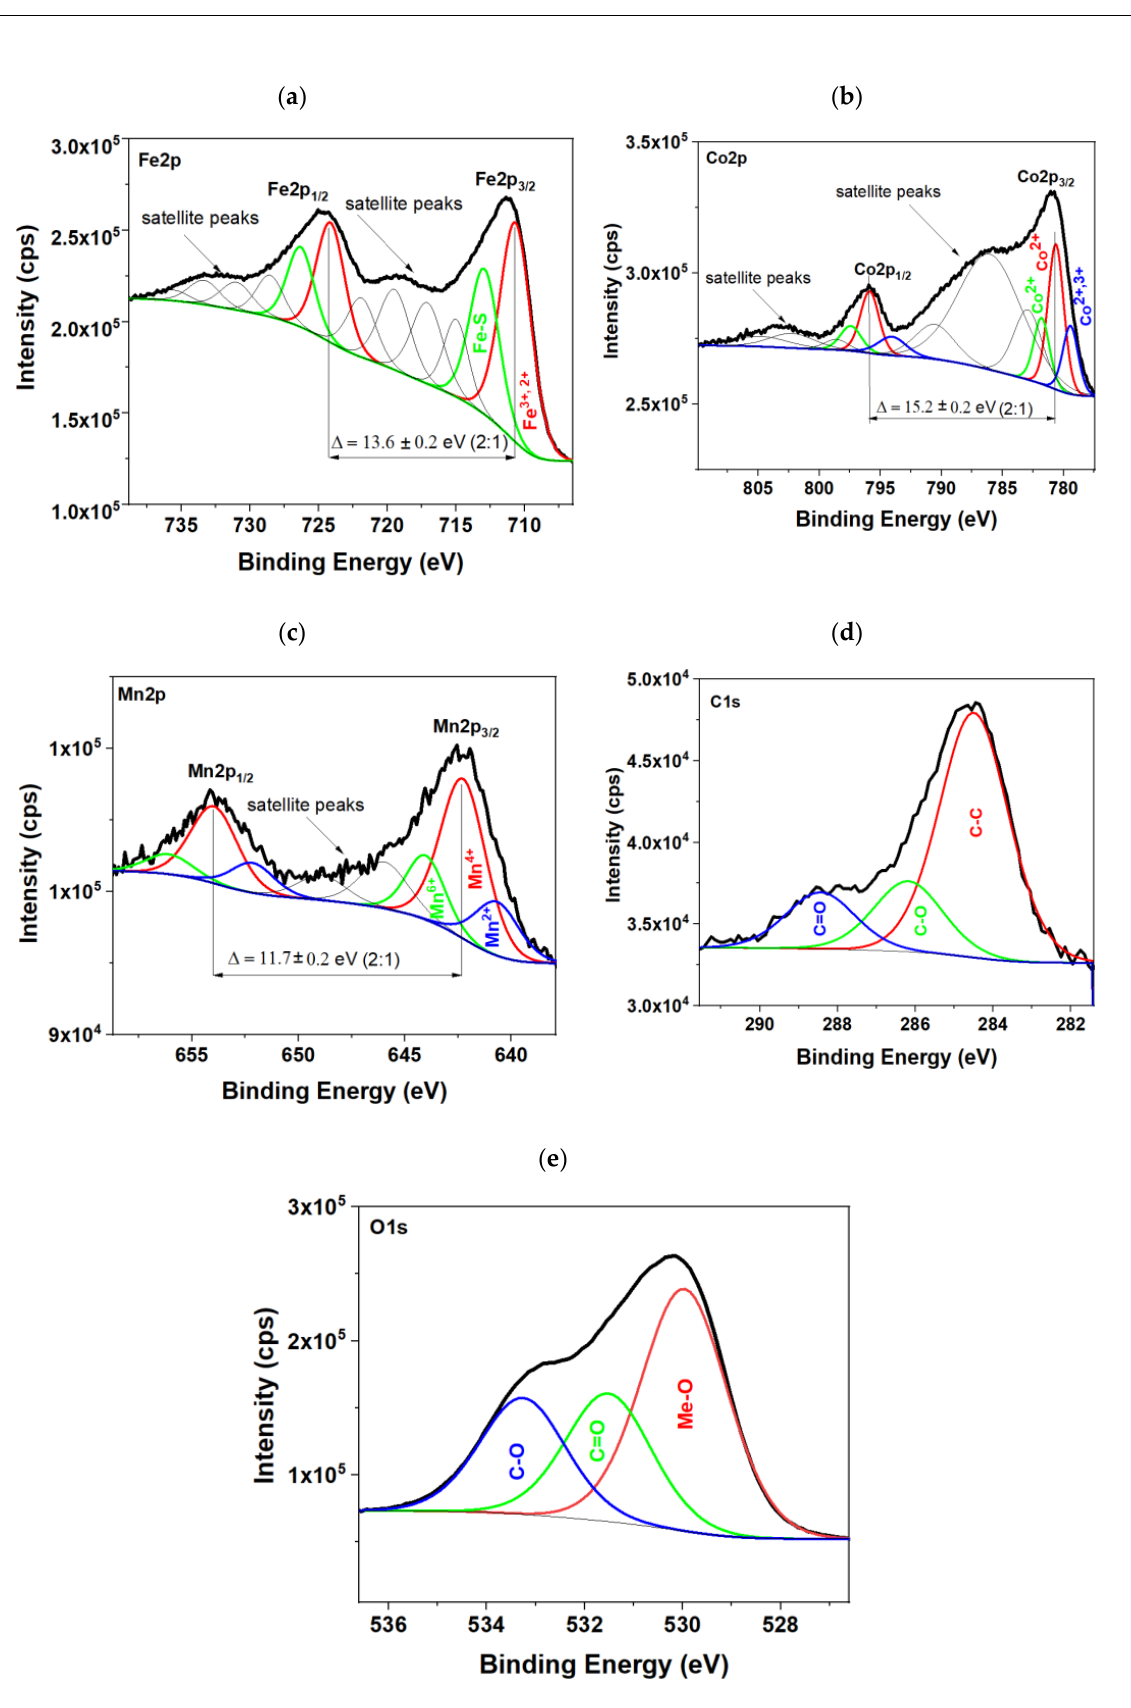
Figure 6. XPS spectra for sample 1 chosen for MRF synthesis, in particular, ( a ) Fe 2p, ( b ) Co 2p, ( c ) Mn 2p, ( d ) C 1s, and ( e ) O 1s core level spectra.